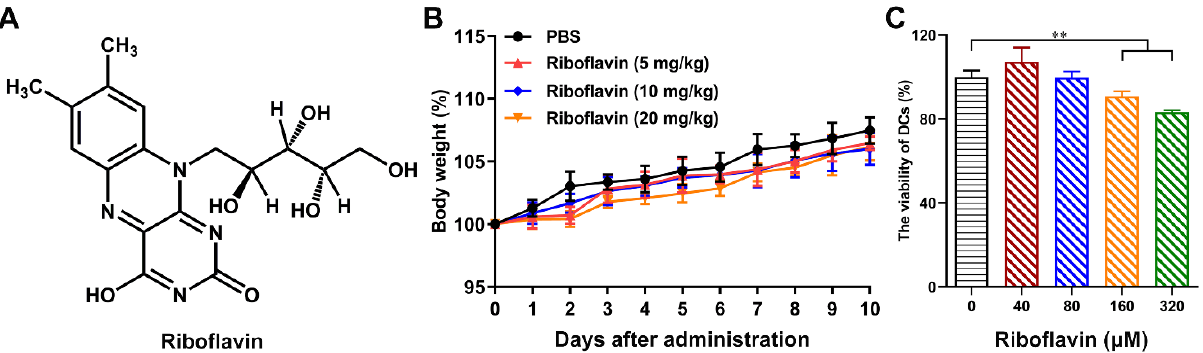
Figure 1. Biosafety of riboflavin in vivo and in vitro. ( A ) Chemical structure of riboflavin. ( B ) Riboflavin at different concentrations (5, 10, and 20 mg/kg body weight) was intranasally administered to mice. The body weight of the mice was monitored continuously for 10 days ( n = 10/group). ( C ) The cytotoxicity of riboflavin (40 μ M, 80 μ M, 160 μ M, and 320 μ M) in DCs was detected by the CCK-8 assay. All of the data are presented as the mean ± SD. Statistical significance was assessed by one-way ANOVA to compare the results between different groups; ** p < 0.01.